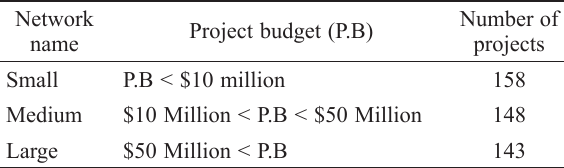
Table 6. Information about the cost-based networks